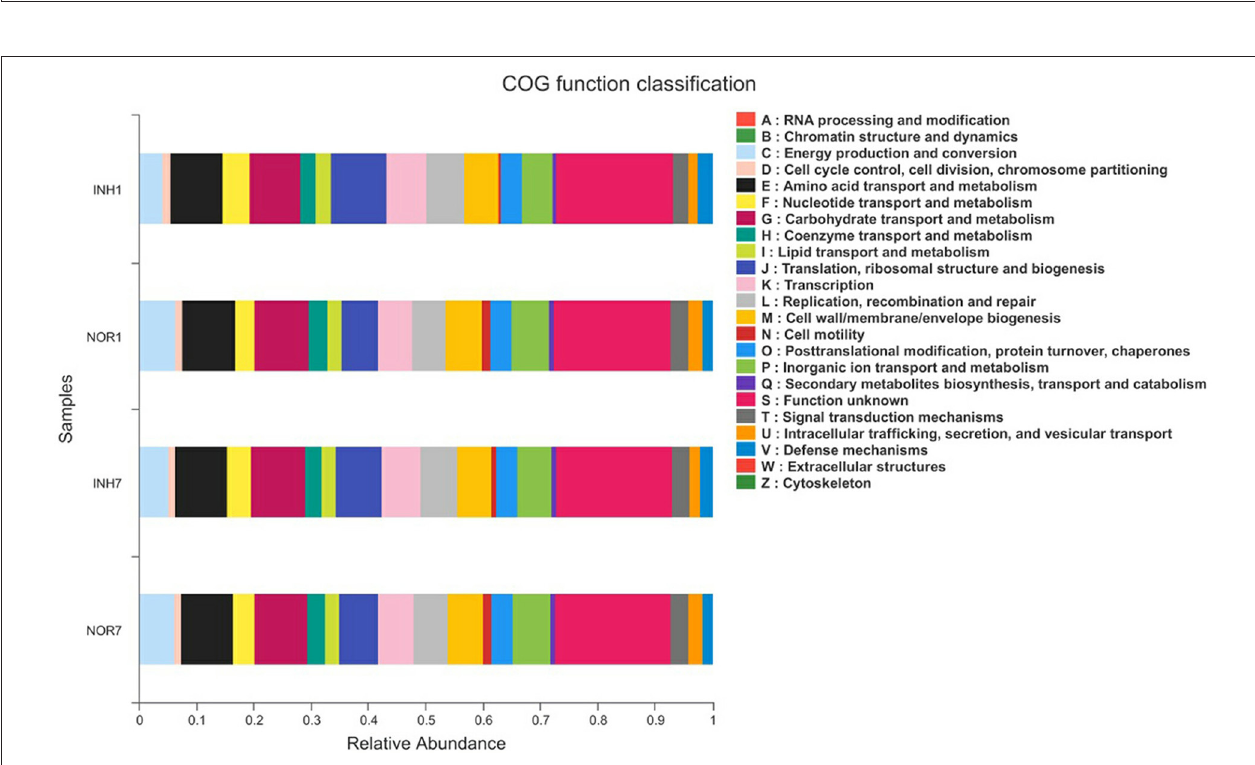
FIGURE 8 | The X-axis represents the average relative abundance of a function in different groups, and different colors represent different functions. The Y-axis represents different groups.